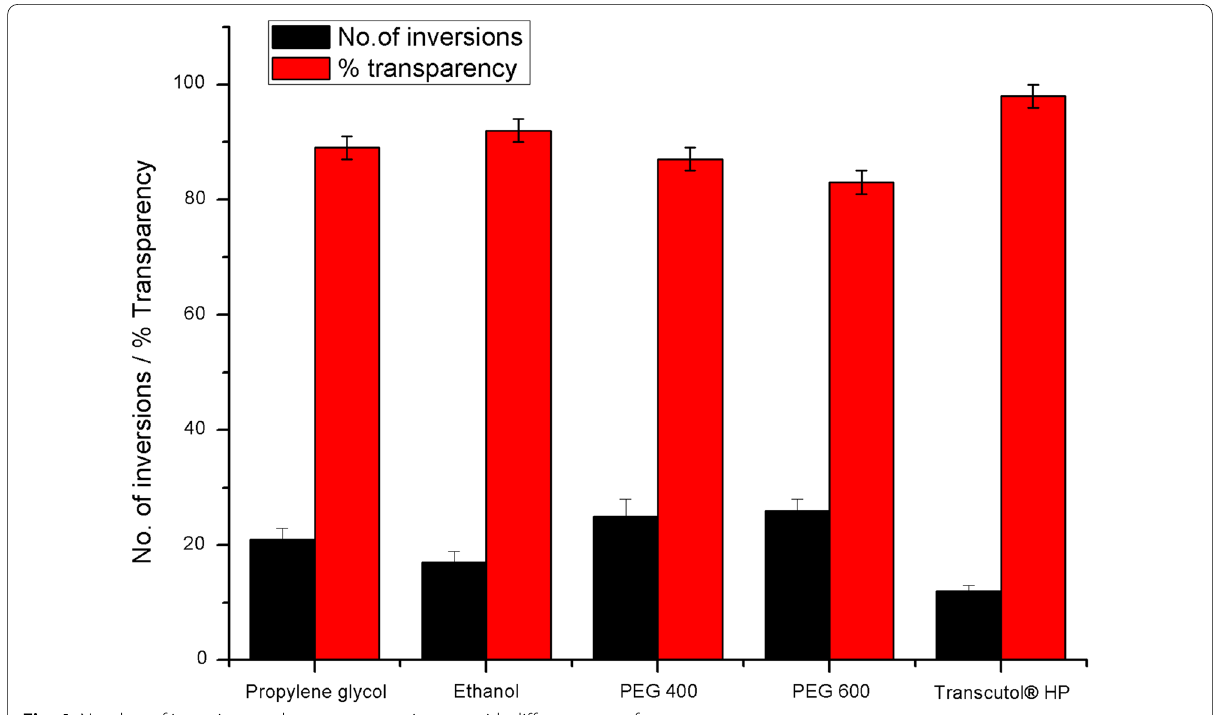
Fig. 4 Number of inversions and percent transmittance with different co-surfactants